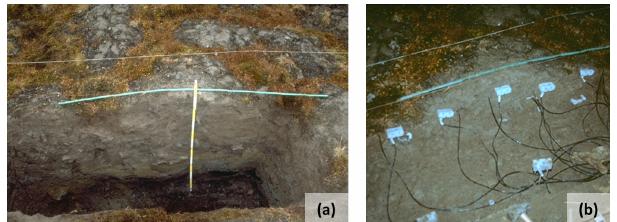
Figure C8. Bayelva soil station, September 1998–January 2012, (78.92094 ◦ N, 11.83334 ◦ E). (a) Soil profile in non-sorted circle (down to 120cm below ground surface); (b) TDR and temperature probes. Soil texture and C, N and S data are listed in Table F1.